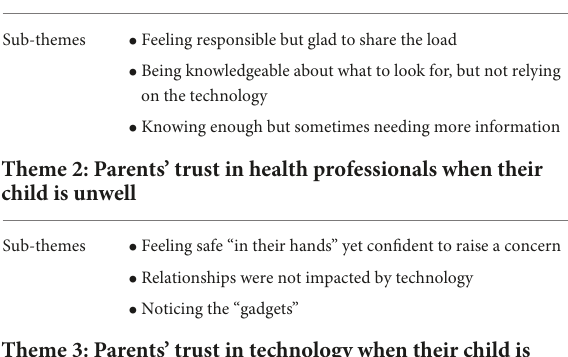
TABLE 3 Main themes and